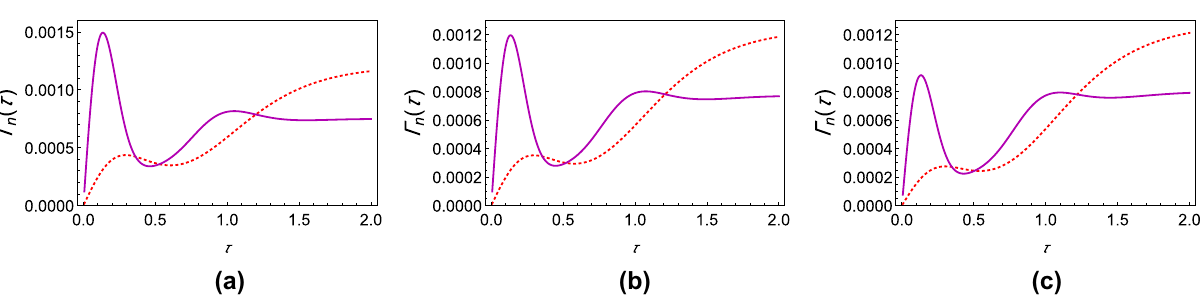
Figure 8. Transitory behavior in the modified decay rates. All is the same as in Fig. 4 except that we have modified decay rates, and the θ values for ( a ), ( b ), and ( c ) are θ